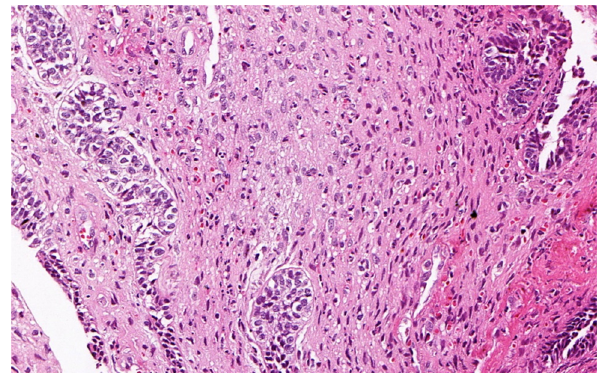
Histopathological findings. Biphasic pattern with benign odontogenic epithelium surrounded by sarcomatous component with intense cellular and nuclear pleomorphism and mitotic figures (H&E stain, 200 × ).